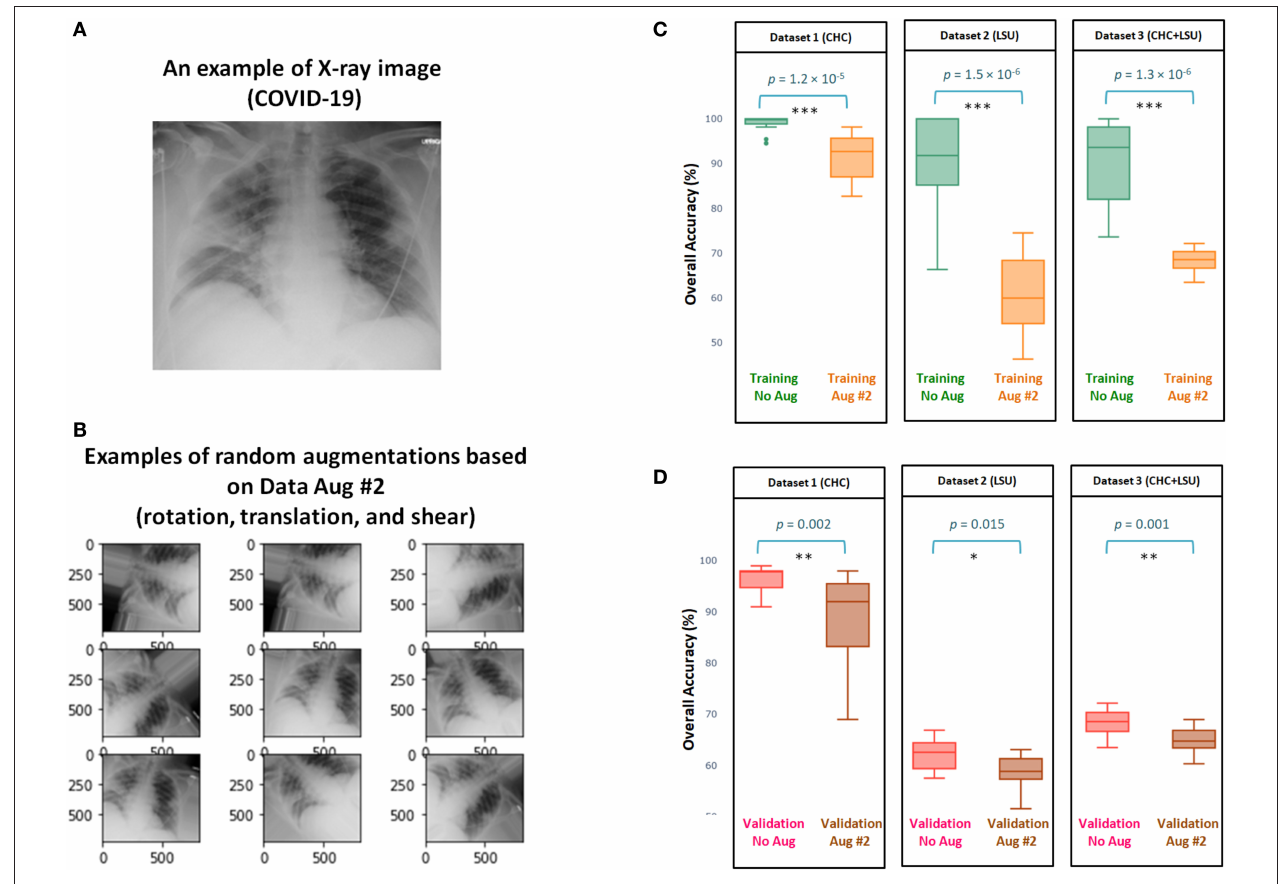
FIGURE 2 | Efficacy of Data Augmentation 2 (22) on X-ray images with and without COVID-19. (A) An example of applying Data Augmentation 2, which includes shear operation within the range [ − 30, 30], random rotation within the range [ − 90, 90], and random translation from pixel range [ − 10, 10] to a COVID-19 X-ray image. (B) Comparing the overall accuracy of 17 deep neural networks to examine the efficacy of Data Augmentation 2 (21) when applied to three datasets. (C) Boxplots to show the overall statical different between training with and without augmentation over three datasets. (D) Boxplots to show the overall statical different between validation with and without augmentation. Note that results shown in (C,D) are obtained from cross validation with K =